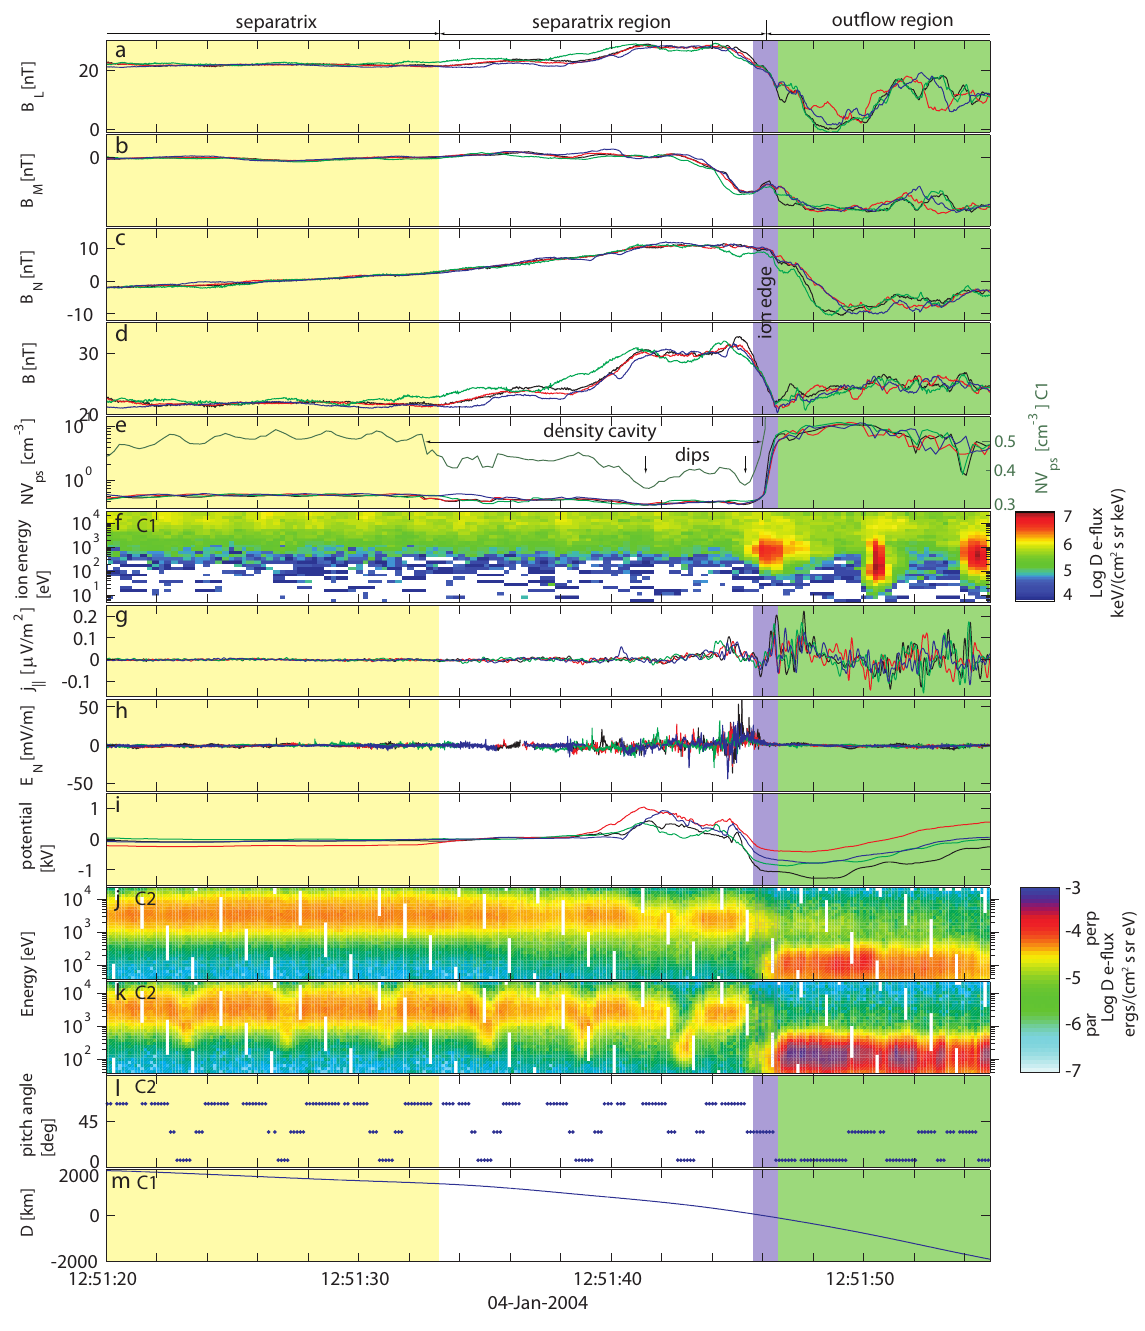
Fig. 9. Cluster crossing from the magnetosphere into the reconnection layer on 4 January 2004, 12:51UT. Format of the figure is the same as for Fig. 8. The LMN -directions are : L =[ − 0.21 − 0.95 0.25], M =[ − 0.08 0.27 0.96], N =[0.92 0.40 − 0.04] in GSE. The velocity of the discontinuity is v dis =176[ − 0.92 − 0.40 0.04]km / s GSE. The time axes for spacecraft 1–4 are shifted by [ − 0.42 0 − 1.40